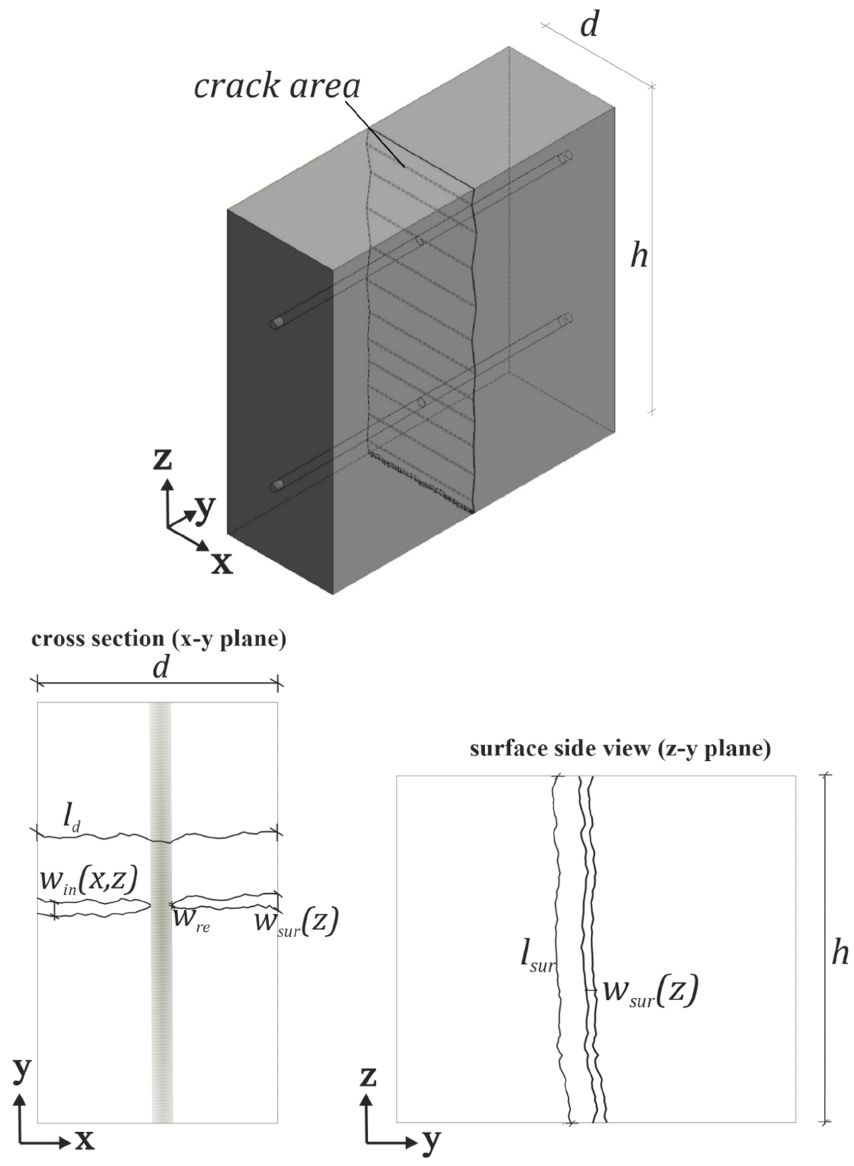
Figure 1. Schematic illustration of a separating crack in reinforced concrete. At present, several permeation models assume cracks as smooth parallel plates and only consider the surface-crack width w sur (z) and surface-crack length l sur of the crack fluencing factors being stress state in the cross-section, reinforcement and concrete geometry. Usually, the theory of laminar flow of incompressible Newtonian fluids through parallel plates is used for permeation models, e.g., Poiseuille’s law [48], Equation